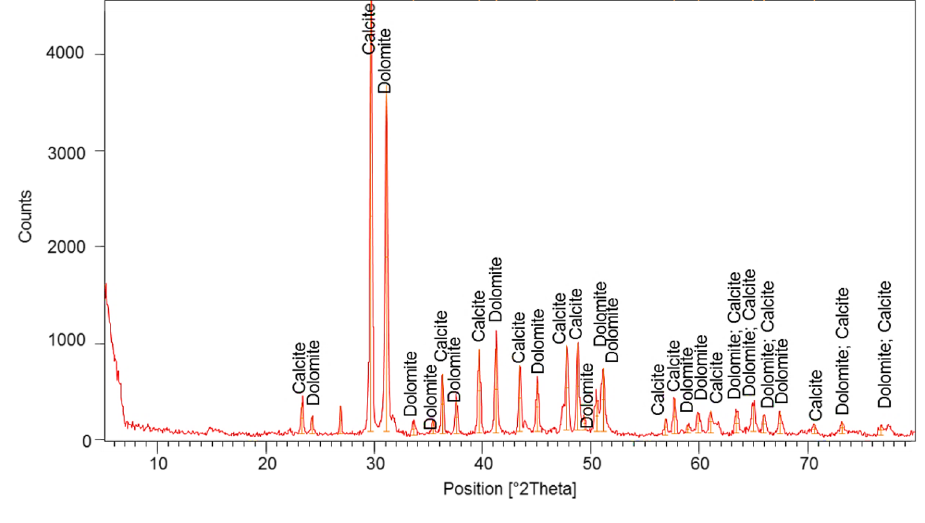
Table 2 Formulation of Vitagnus surfactant solutions used in this